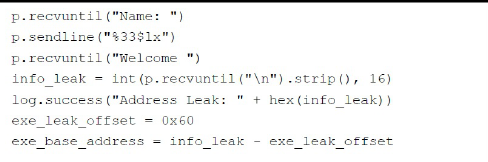
Figure 25. Python Script Part